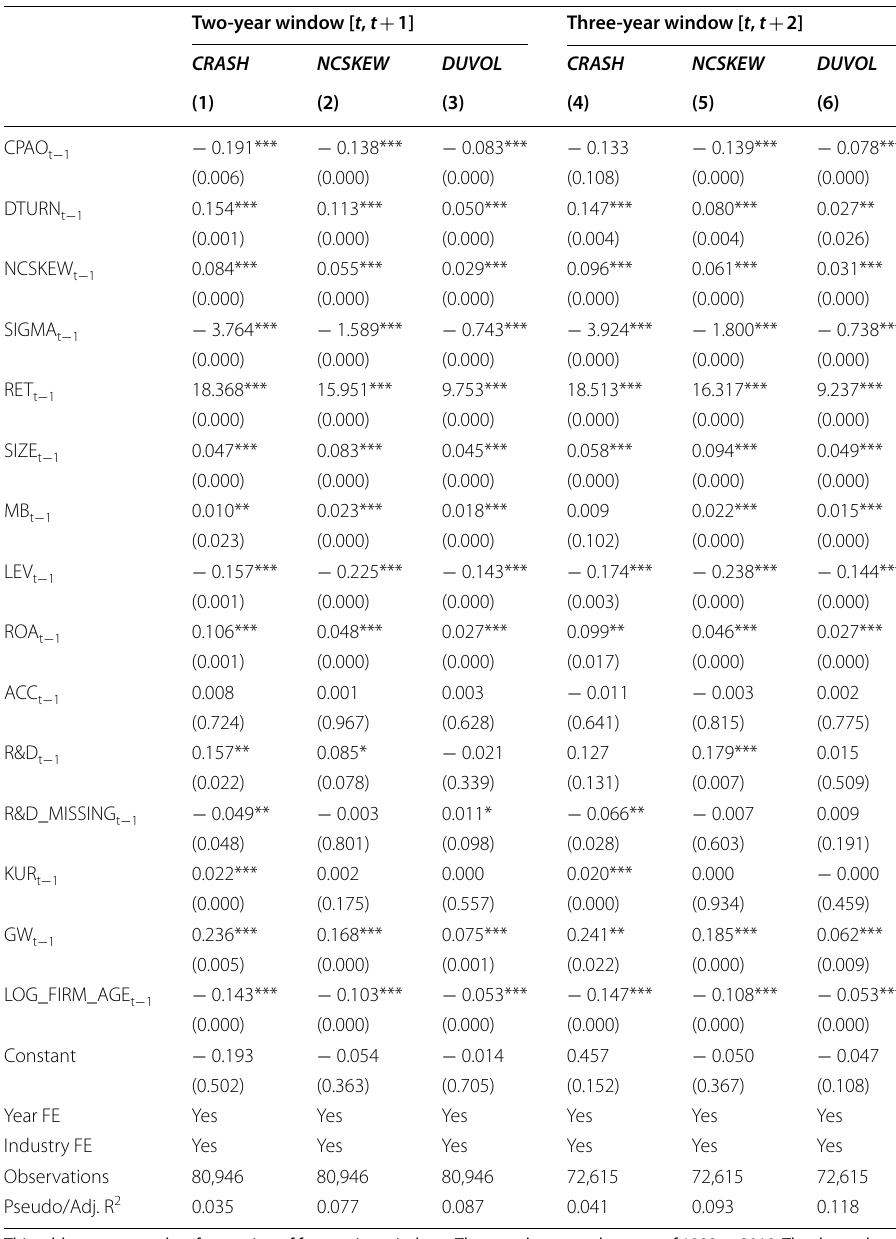
Table 7 Extension of forecasting